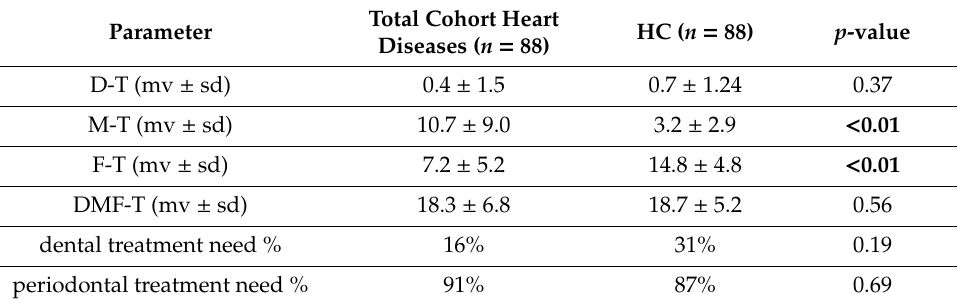
Table 3. Oral conditions and treatment need between patients with heart diseases (total cohort including HF, HTx and LVAD at baseline) and the healthy comparison